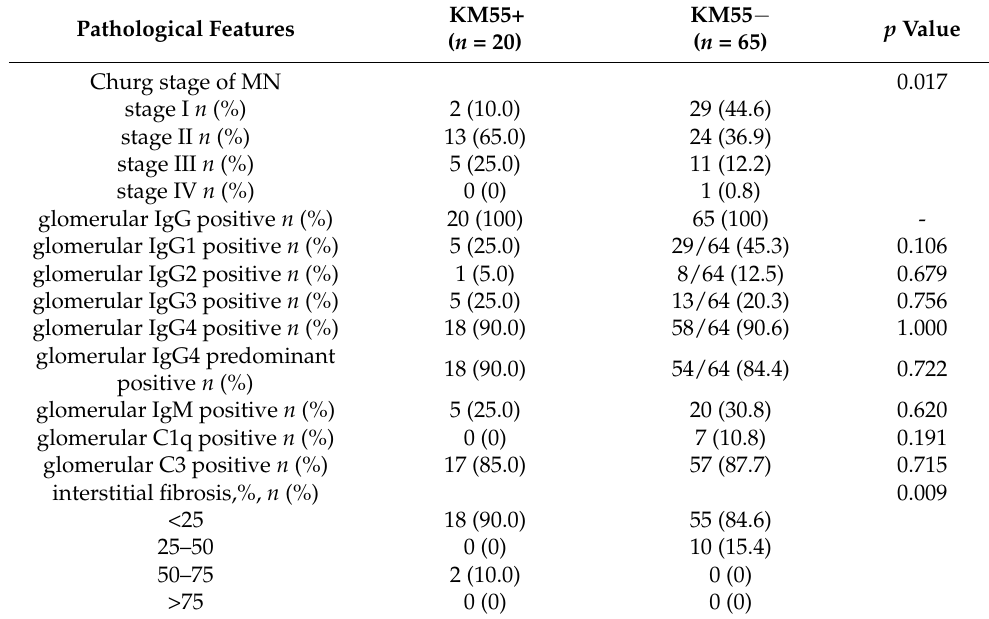
Table 5. Pathological features in PMN/IgAN patients based on the staining of glomerular KM55. Pathological